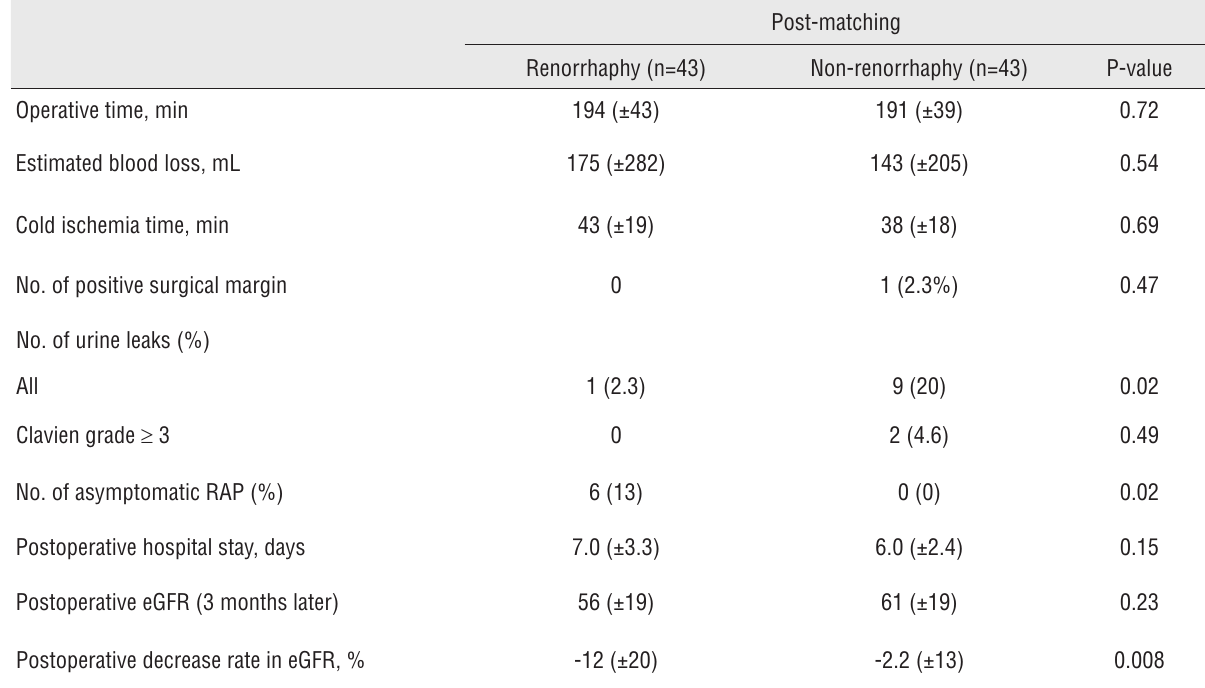
Table 2 - comparison of surgical